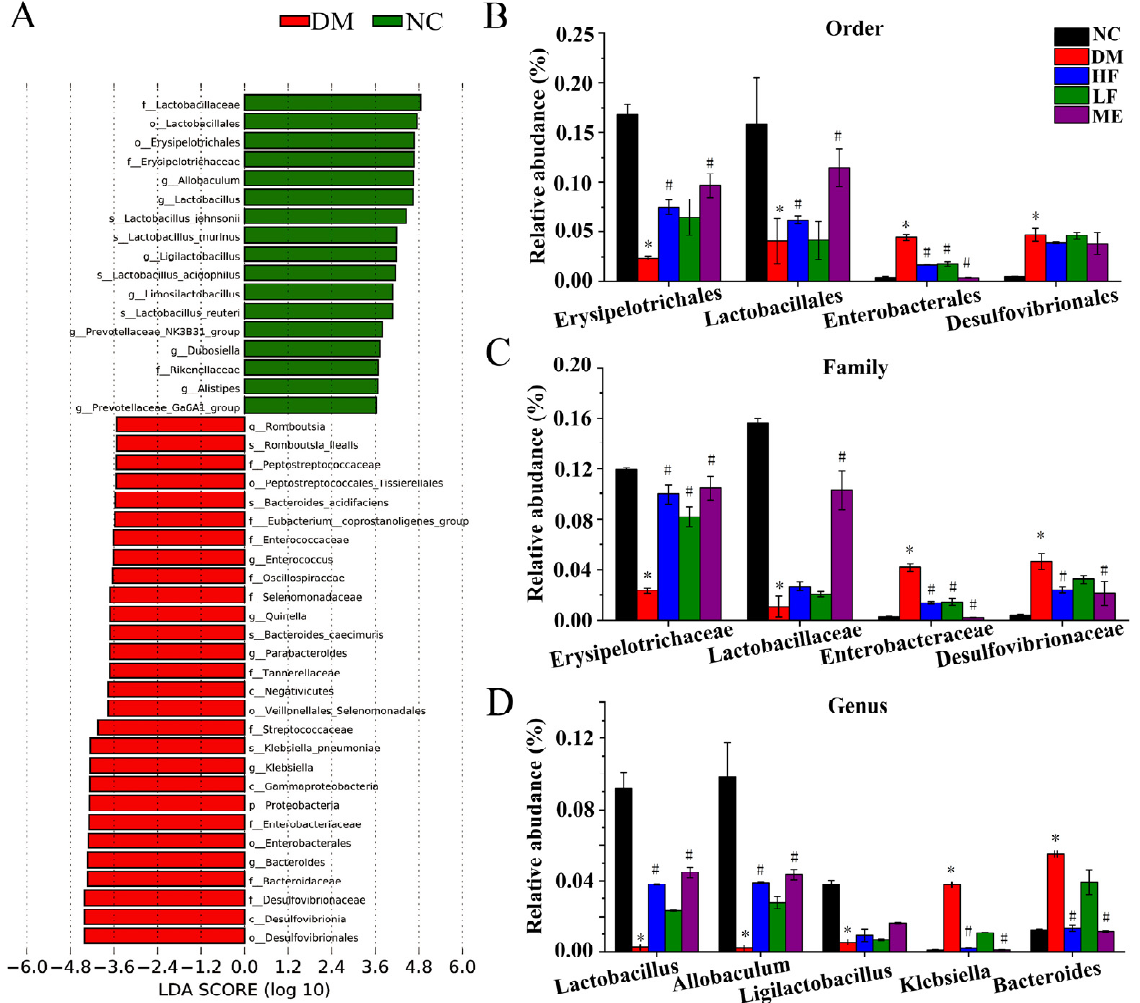
Figure 7. Analysis of key taxonomic taxa. LDA between the NC and DM groups ( A ). Comparative analysis of key bacteria at the order ( B ), family ( C ), and genus ( D ) levels. * p < 0.05 vs. NC group, and # p < 0.05 vs. DM group.